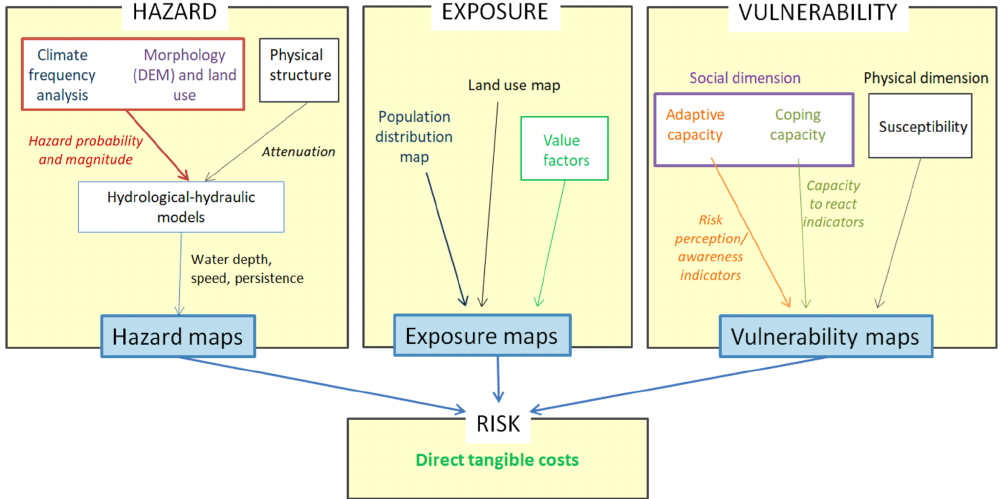
Figure 3. Flowchart outlining the determination of risk in a flood risk assessment context.